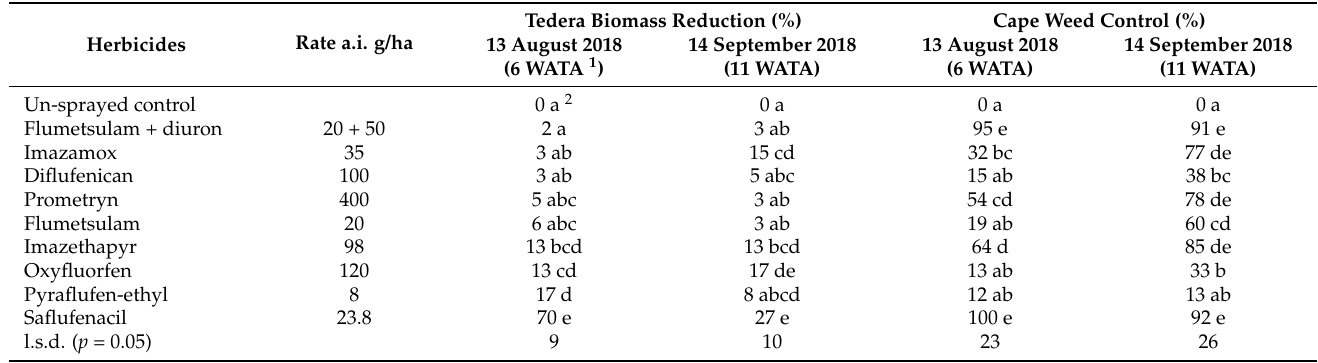
Table 7. Response of capeweed and a 1-year-old tedera stand to post-emergent broadleaf herbicides applied on 28 June 2018 at Dandaragan.